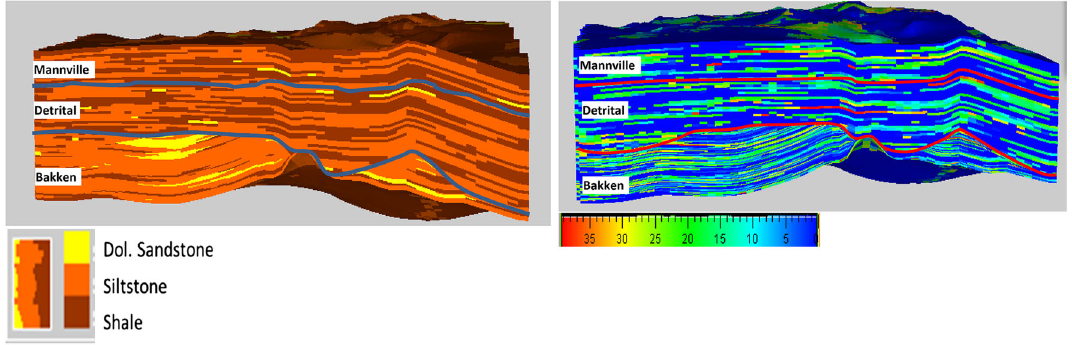
Fig. 6 Distribution of facies (rock types) and porosity